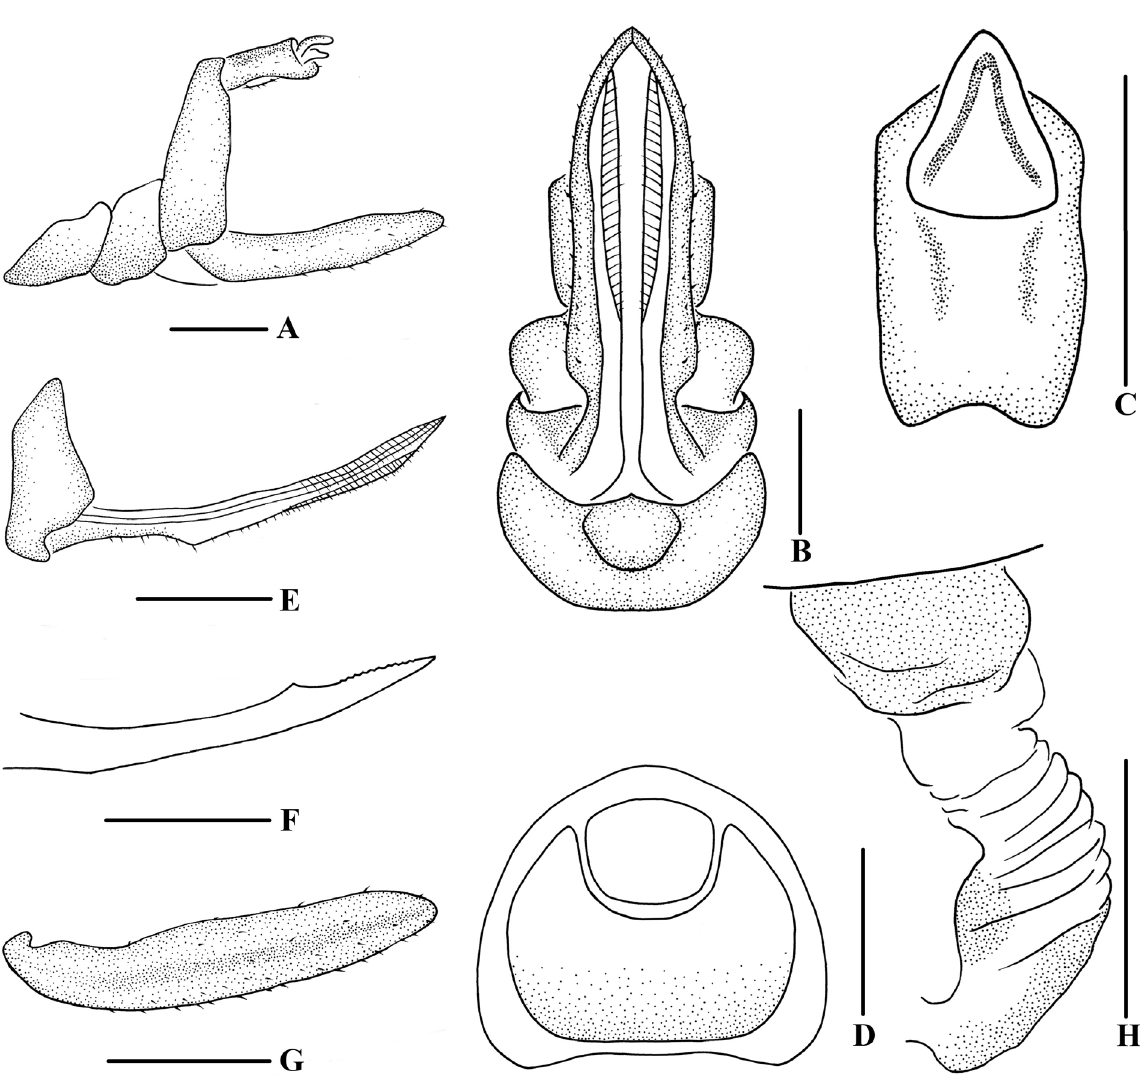
Fig. 6. Andes furcutus Wang, Zhang & Chen sp. nov., ♀. A . Genitalia, lateral view. B . Genitalia, ventral view. C . Anal segment, dorsal view. D . Tergite IX, caudal view. E . Gonapophysis VIII and gonocoxa VIII, dorsal view. F . Gonapophysis IX, lateral view. G . Gonoplac, inner lateral view. H . Posterior vagina, ventral view. Scale bars: 0.5